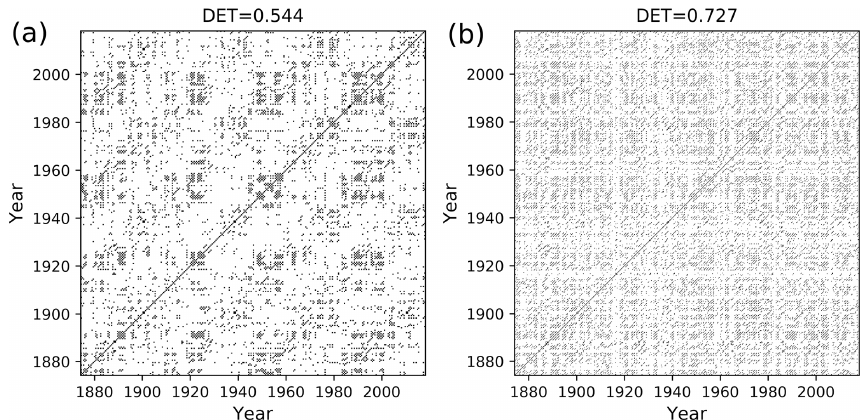
Figure 14. Recurrence plot of flood events using ED, window size = 1 year, with (a) 6 months of overlapping and (b) 9 months of overlapping.